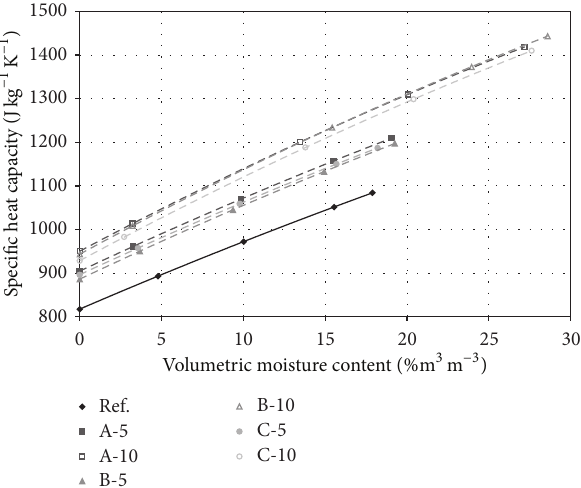
Figure 4: Influence of moisture and coir pith additive on specific heat